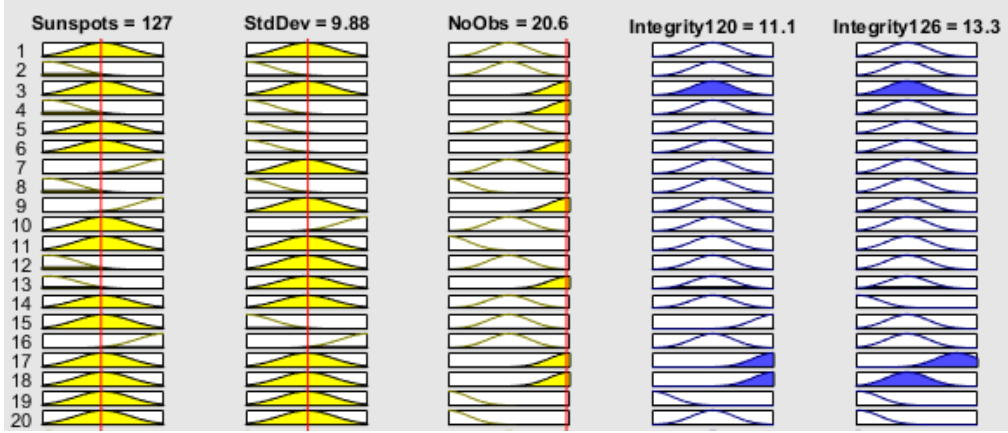
Figure 8. Graphical interpretation of the model defuzzification (Own study in MATLAB Fuzzy Logic